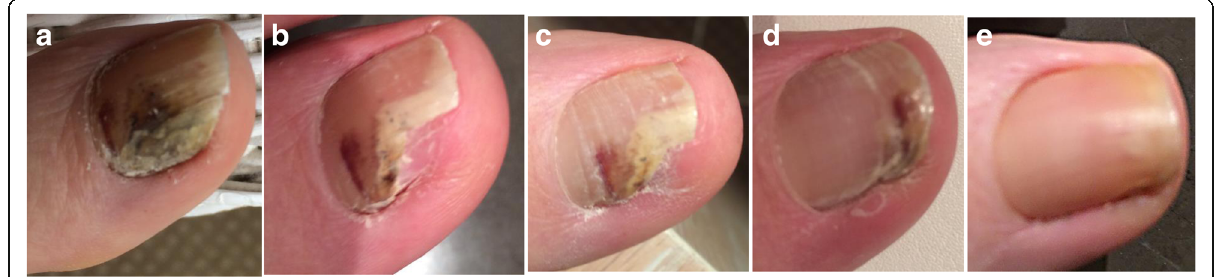
Fig. 5 Case 1: Calmagen® lotion cleared onychomycosis in a 50+ year-old Caucasian male who had the condition for 4 years and tried different treatments which failed. Before treatment ( a ); 1 month after treatment ( b ); 2 months after treatment ( c ); 8 months after treatment ( d ); 13 months after treatment and 2 months after stopping treatment ( e